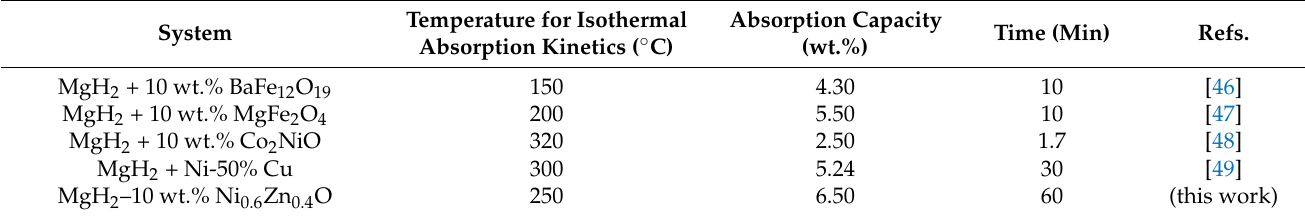
Figure 3. ( a ) Temperature-programmed-desorption curves, ( b ) Absorption kinetics at 250 °C, 33.0 atm and ( c ) Desorption kinetics at 300 °C, 1.0 atm.